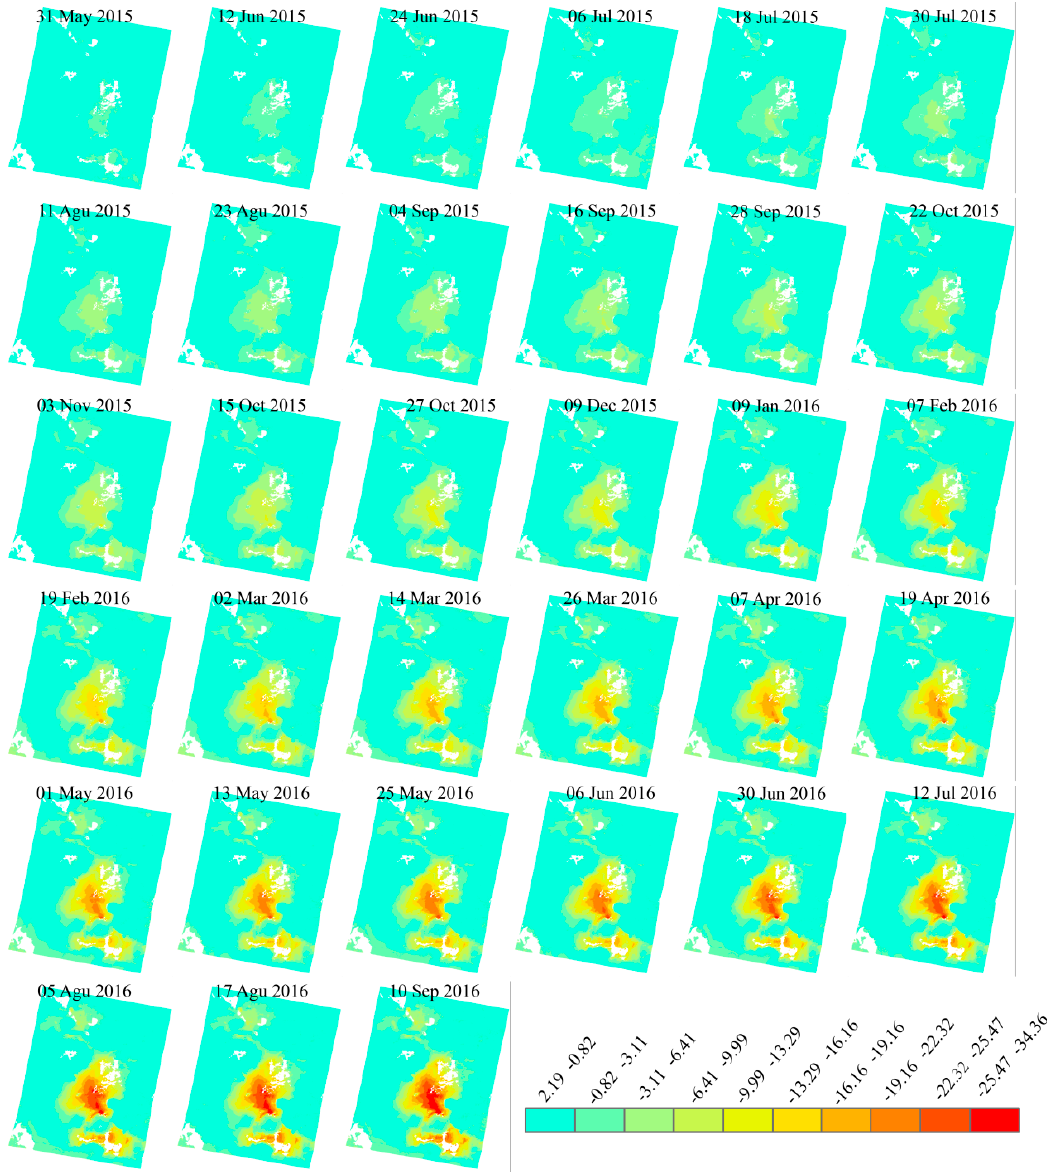
Figure 6. Displacement time-series along LOS direction with unit weights by Method (unit: cm). The negative value represents the increased distance between ground target and satellite antenna direction.